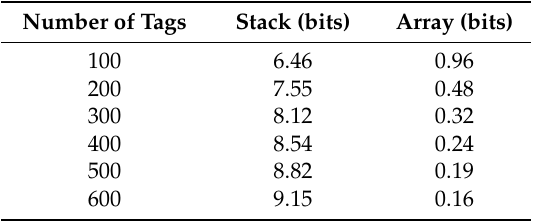
Table 2. Storage scheme